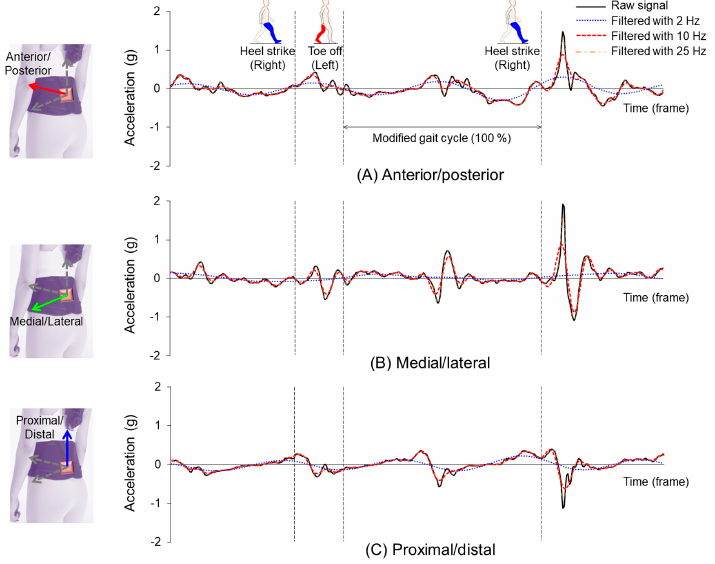
Figure 4. Representative three-axis acceleration signal acquired from the IMU device attached to the waist region.